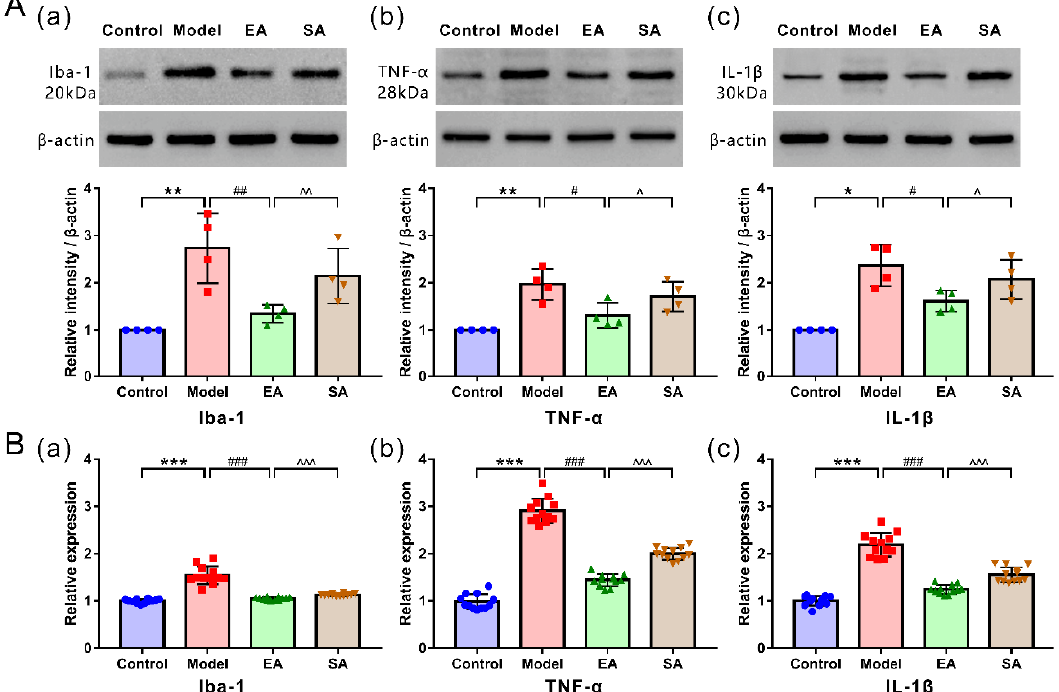
Figure 3. Levels of protein and mRNA expression of Iba-1, inflammatory cytokines (IL-1 β and TNF- α ) in the TNC among groups. ( A ) Western blot analysis and band density quantification of Iba-1 and inflammatory cytokines (IL-1 β and TNF- α ) ( n = 4). ( B ) mRNA expression of Iba-1, inflammatory cytokines (IL-1 β and TNF- α ) by RT-qPCR ( n = 12). Protein expression: Mann–Whitney nonparametric test; mRNA expression: One-way ANOVA followed by post hoc Tamhane test. Data are mean ±